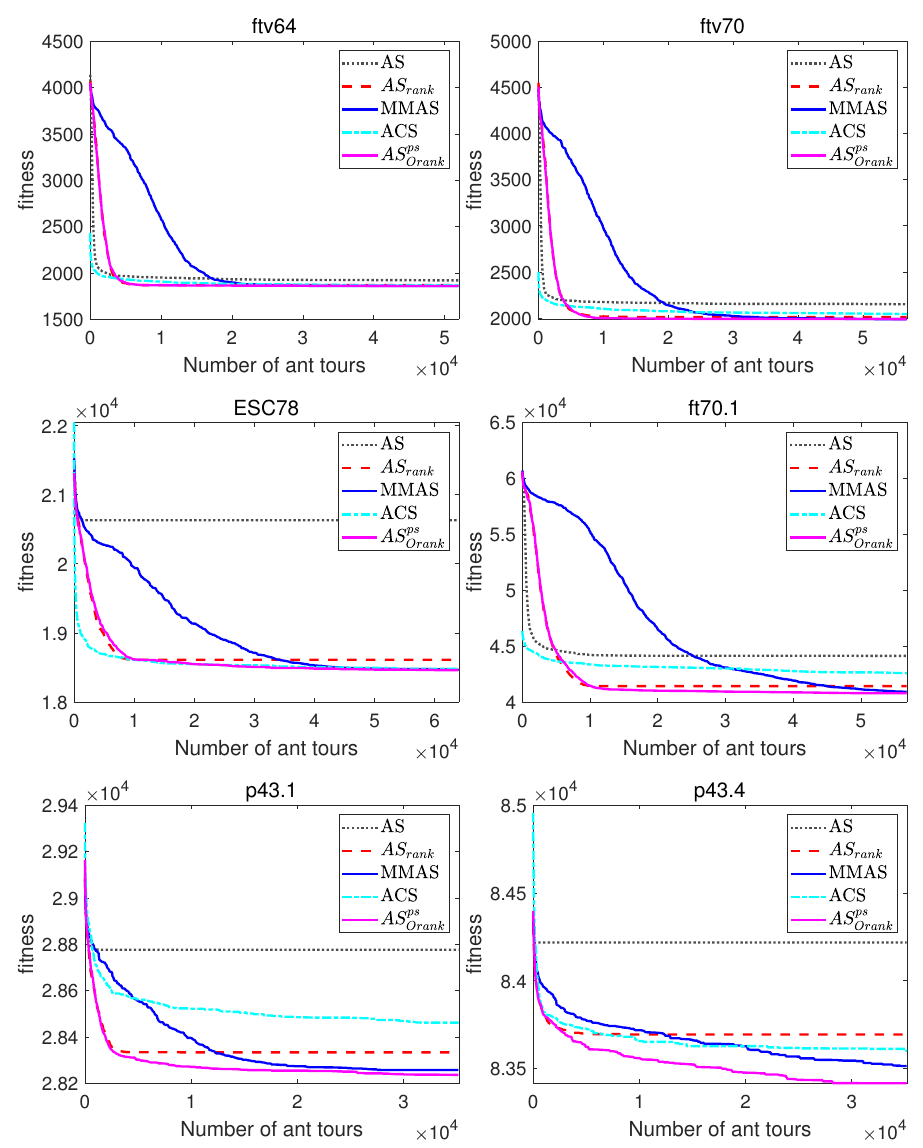
Figure 7. Evolutionary curves of ACO algorithms for asymmetric TSP instances ( ftv64 and ftv70 ) and four SOP